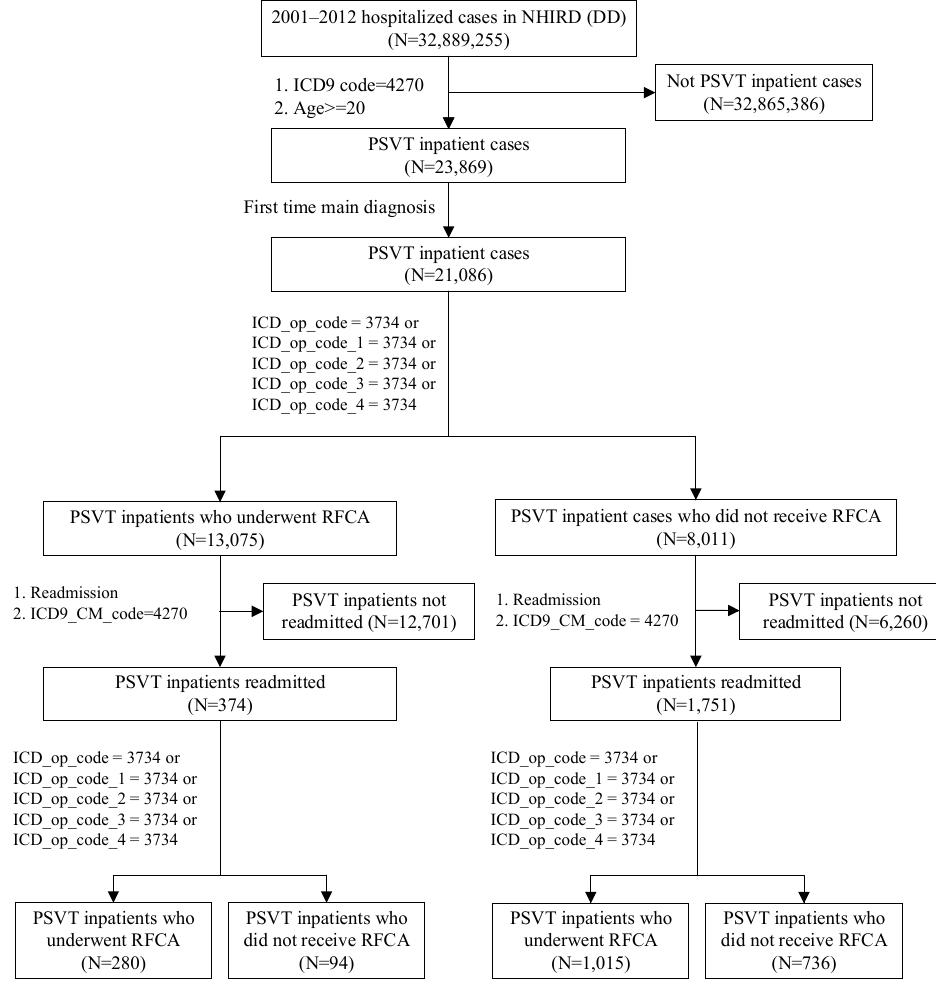
Figure 1. Data ‐ processing flow chart. Figure 1. Data-processing flow